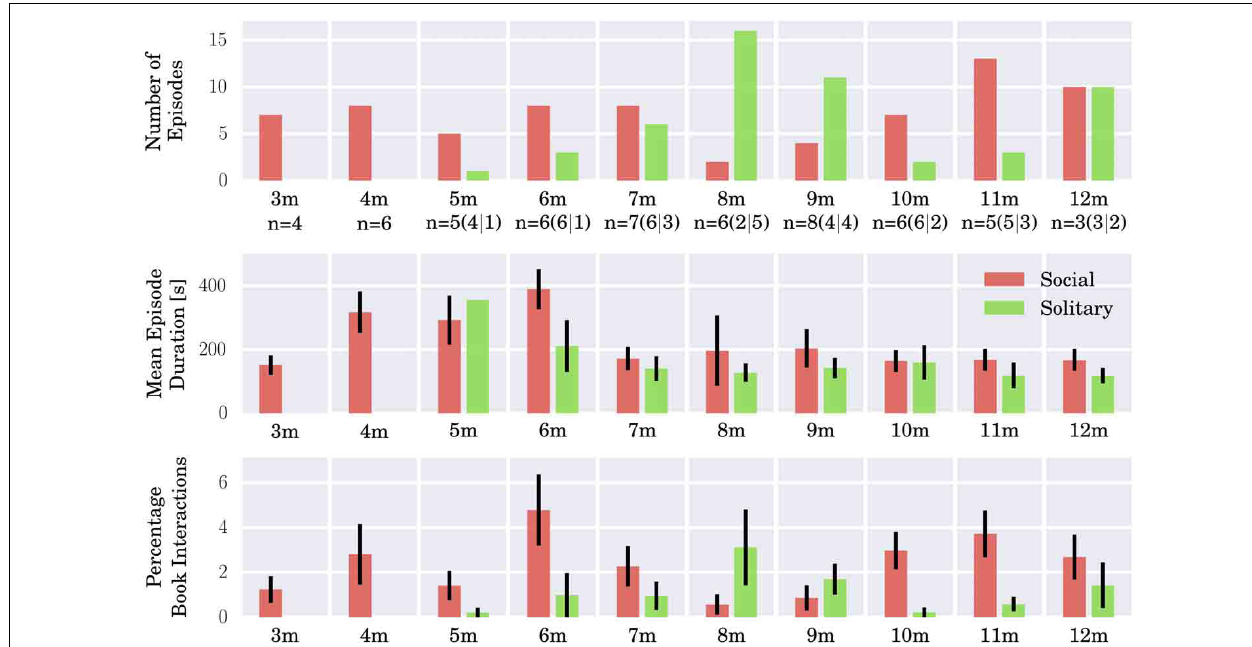
FIGURE 1 | Social book sharing interactions (red) and solitary book exploration episodes (green) for all infants from 3–12 months. Top: Number of episodes for each month. In addition, the absolute number (“ n = ”) of individual infants represented in the sample (out of the total of 10) is also given below the bar graph, first in total and then in brackets for social and solitary interactions, respectively, as one infant may engage in multiple